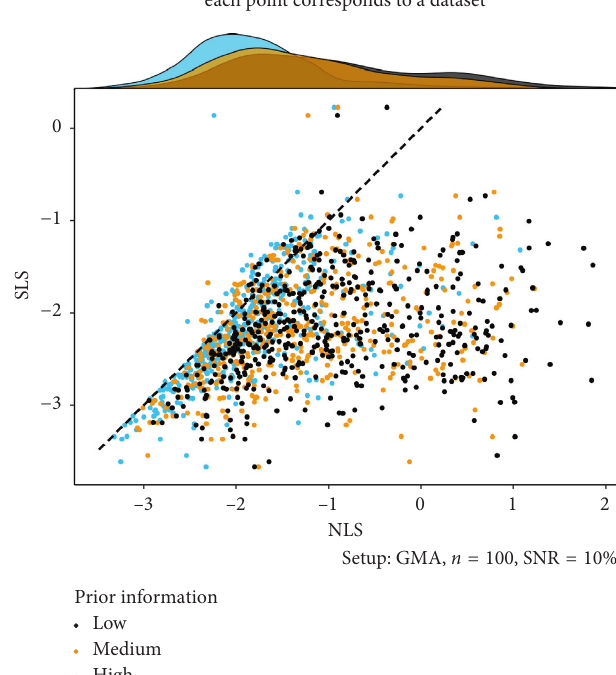
Figure 2: The plot visualizes the performance (on a log scale) of NLS and SLS according to criteria (5) and (7), which are evaluated at the optimal parameter estimates. Points in the scatterplot are colored according to the quality of prior information used to compute the NLS estimates. The 45 ° diagonal line passing through the origin has been added for reference and intuitive assessment. The scatterplot is supplemented with marginal density estimates using the same color coding. The density estimates indicate that, as the quality of prior information degrades, the quality of NLS results suffers, which manifests in longer right tails of the densities. By definition, performance of SLS is not affected by the quality of prior information on linear parameters. For high-quality prior information, clustering of losses in the scatterplot close to the reference line suggests that the overall performance of both NLS and SLS is comparable. As the quality of prior information decreases, the point clouds spread to the right, indicating that SLS starts to perform noticeably better than NLS. Furthermore, unlike Tables 1 and 2, the scatterplot and the range frame (see [57]; pp. 130–132) convey an impression of the variability in the estimation results over multiple datasets: NLS is visually more variable than